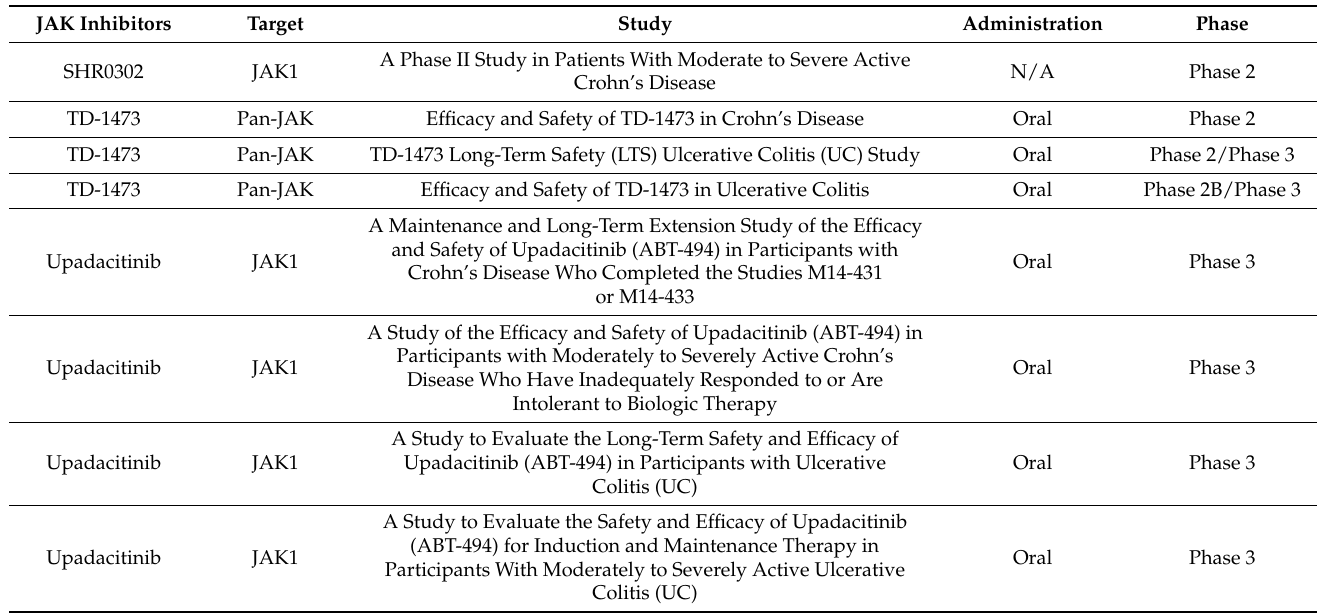
Table 1. Current clinical trials of JAK Inhibitors in IBD patients. Source: clinicaltrials.gov. Accessed: 5 August 2021. JAK